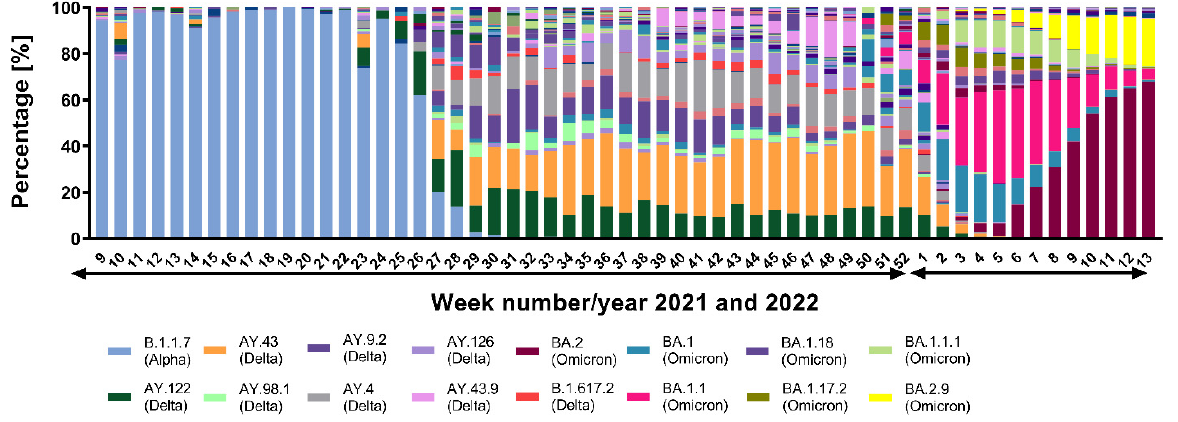
Figure 4. Development of SARS-CoV-2 lineages in SR. Weekly proportions of virus lineages started with dominant VOC Alpha (B.1.1.7) and later in week 26/27 (July/2021) with rapid onset of Delta (B.1.617.2) splitting into many lineages. New VOC Omicron (BA.1.1.529) began to outcompete Delta (B.1.617.2) in week 51/52 (December/2021) and quickly reaching prevalence and dominating until March/2022.